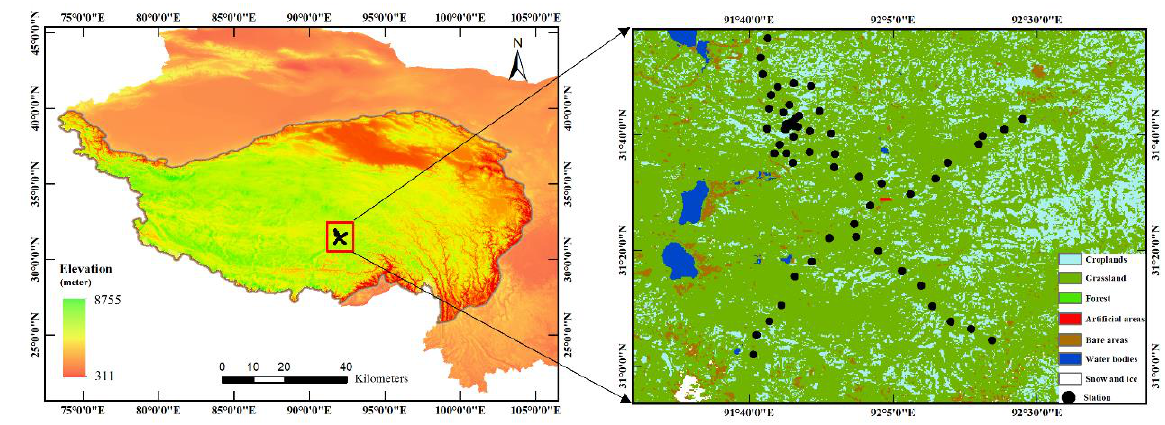
Figure 1. Location of soil moisture stations over Tibetan Plateau.